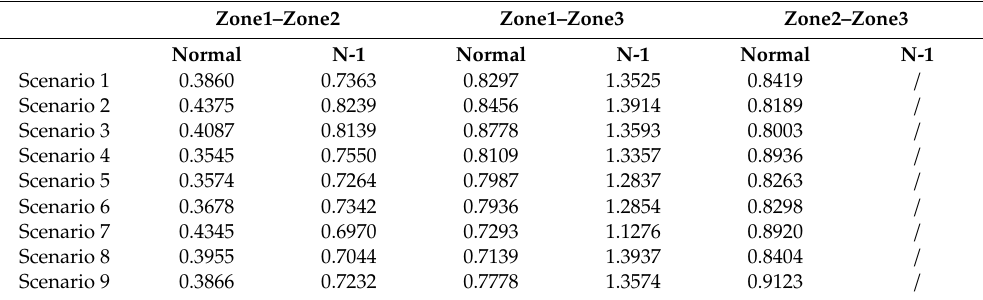
Table 5. Transmission Channel Flexibility